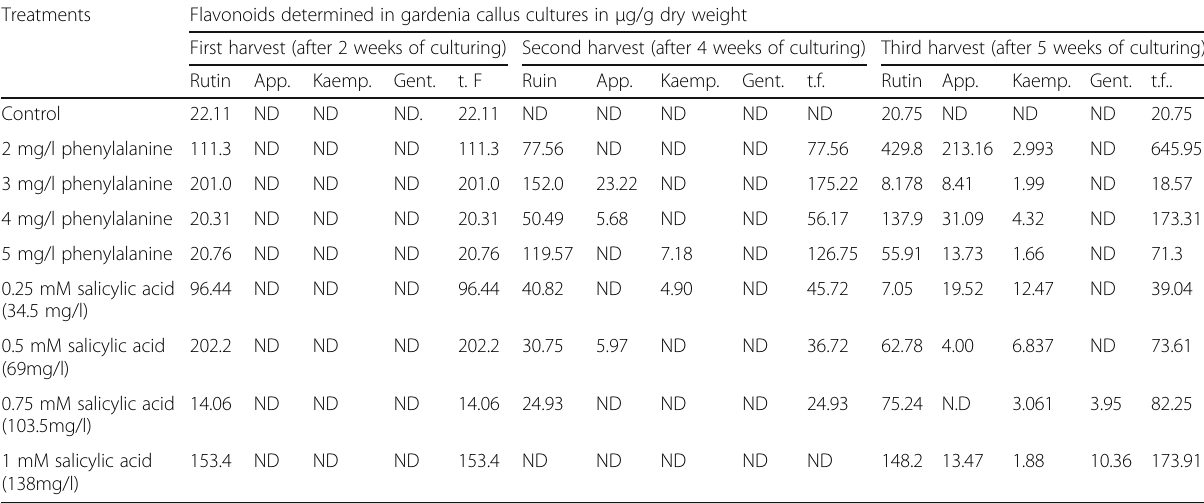
Table 4 Flavonoids determination in gardenia calli cultures cultured on MS media contained different concentrations of phenyl alanine or salicylic acid during the three harvested periods of culturing by HPLC